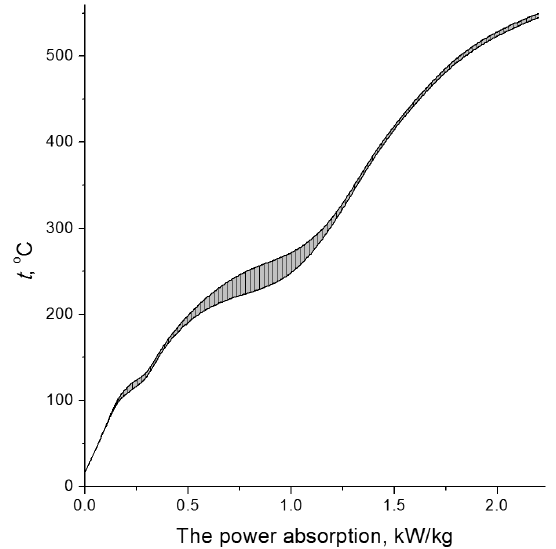
Figure 8. Dynamics of electron-beam heating of cellulose at the dose rate of 2.5 kGy/s (the specific surface area Z of the material is 105 cm 2 /g; the volume density is 150 g/dm 3 ) [13]. The temperature region of distillation of decomposition products is